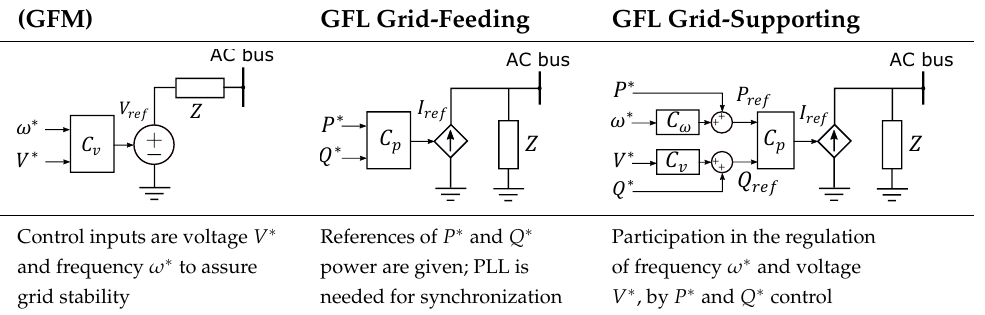
Table 1. Different applications of power converters for AC grids. (GFM) GFL Grid-Feeding GFL